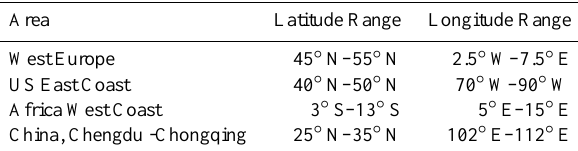
Fig. 3. Scatter plots between AOT and tropospheric NO 2 for four areas: West Europe, US East Coast, West coast of Africa and the area around Chonqing-Chendu in China. The plots in the left col- umn show observations for the period 2005–2007, the right column shows GEOS-Chem simulations for 2005. Open symbols show the winter months (December–January–February) and filled symbols the summer months (June–July–August). Table 1. List of the areas used in Fig.